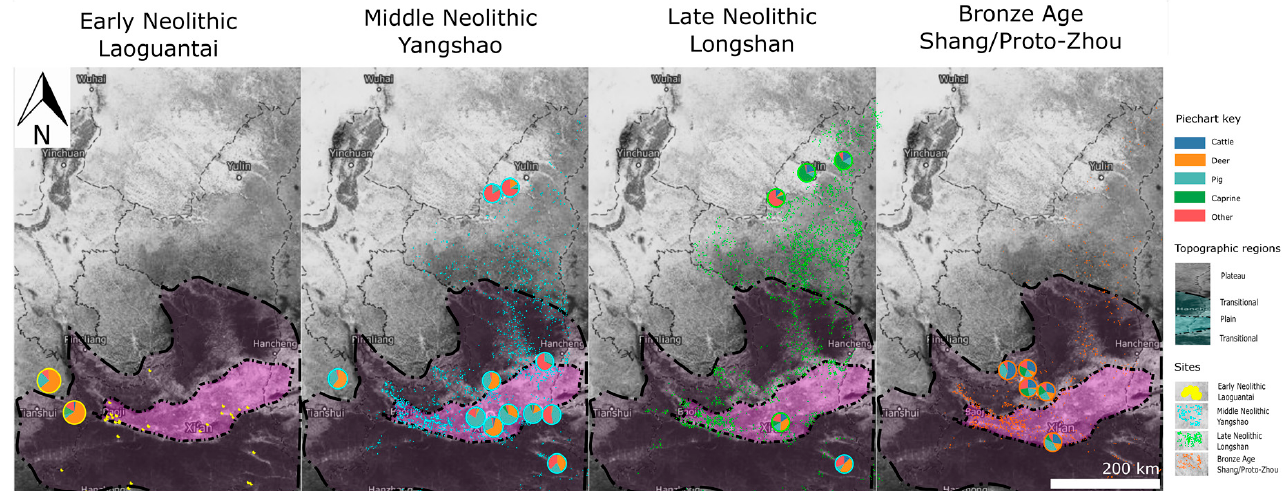
Figure 2. Maps showing the distribution of sites within the study region divided by time period with the three regions highlighted. The pie charts correspond to sites with zooarchaeological assemblages included in this study, while all other sites from each of the time periods are shown as small dots. (N.B. The dots for the Early Neolithic are by necessity larger than those of the periods due to the paucity of sites during this period). (Tableau, F. Monteith).